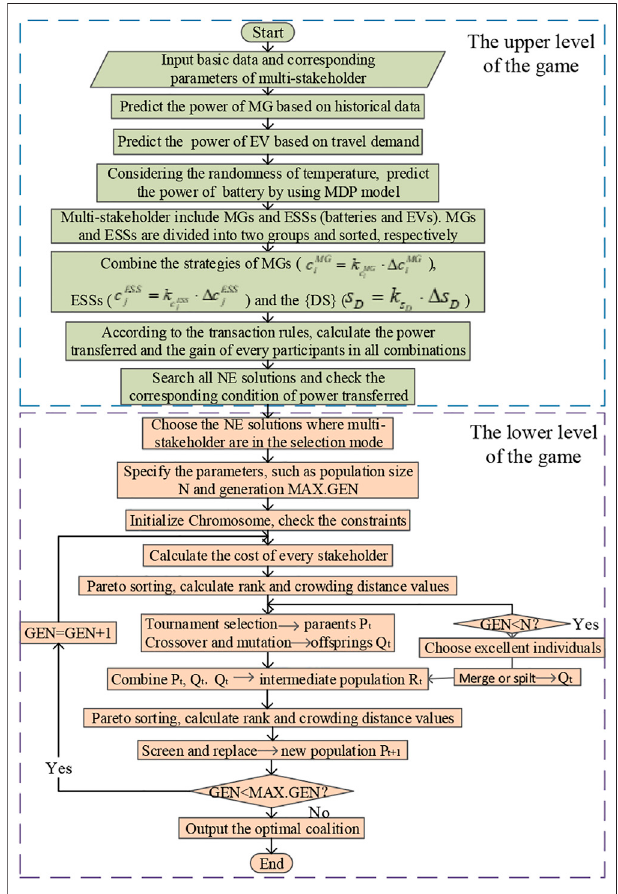
FIGURE 2 | Optimal multi-stakeholder coalition algorithm based on